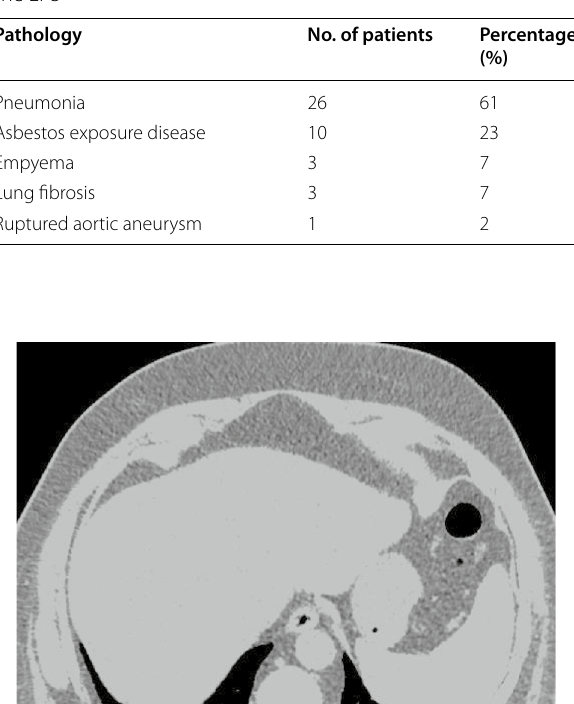
Table 4 Number and percentage of patients with inflammatory conditions leading to fatty expansion and soft tissue stranding of